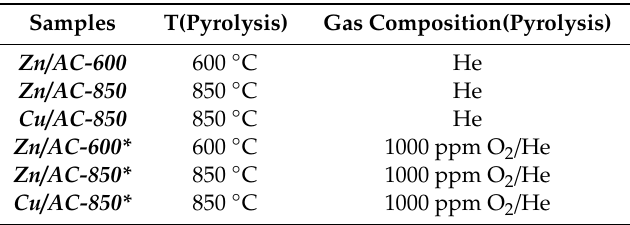
Table 1. List of ACs with the preparation conditions.